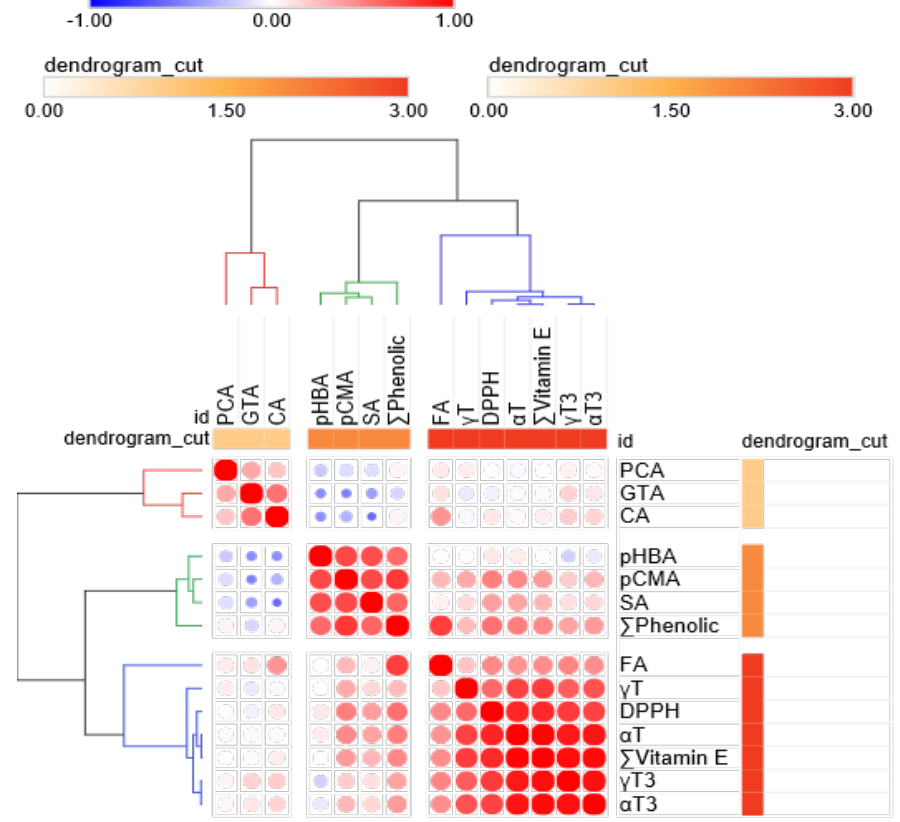
Figure 8. Hierarchical cluster correlation matrix of vitamin E and phenolic compounds in ecofriendly and conventional rice samples. Each circle indicates the Pearson’s correlation coefficient for a pair of compounds, and the correlation coefficient values are represented by the intensity of the blue ( r = −1) or red color ( r = 1), in combination with the circle size, as indicated by the color and size scale.